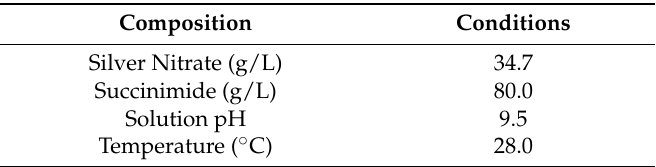
Table 1. Non-cyanide silver plating electroplating bath